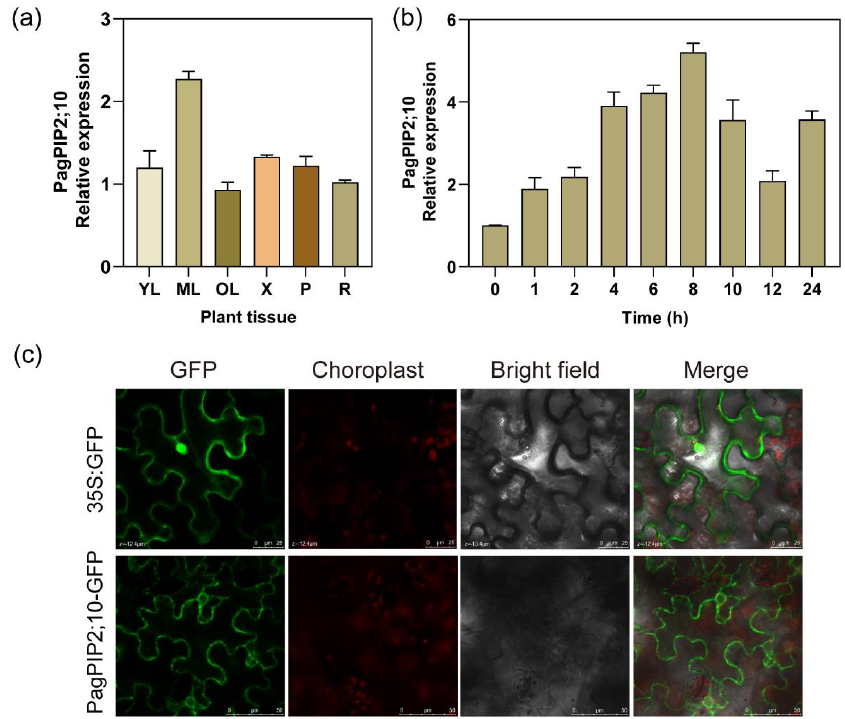
Figure 2. PagNBR1 expression patterns and subcellular location. ( a ) The relative expression levels of the PagPIP2;10 in different tissues, R, root; YL, young leaves; X, xylem; P, phloem; ML, mature leaves; OL, old leaves, ( b ) Relative PagPIP2;10 expression levels under dehydration conditions simulated by 20% PEG 6000; ( c ) Subcellular location of PagPIP2;10 in tobacco leaves. Total RNA was isolated from leaf samples collected at indicated times. Each treatment was performed with three biological replicates (n = 3), and values are means ± SE. * indicates a significant difference compared with the control ( * p < 0.05 ).